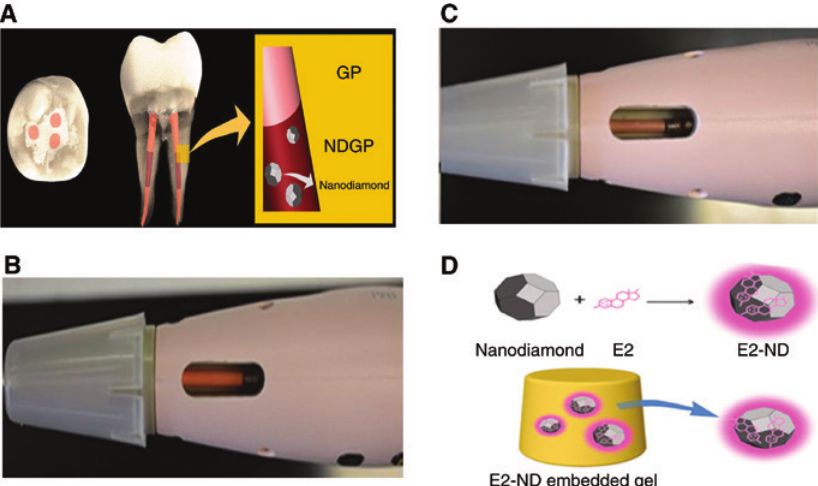
Figure 5: Clinical applications of nanodiamonds. (A) An illustration of NDGP in the middle third of the root canal and unmodified GP in the apical and coronal thirds of the root canal-treated tooth. (B) A view of unmodified GP in the dispensing unit. (C) A view of NDGP in the dispensing unit. Adapted from [78]. (D) A schematic of E2/ND complex embedded within a hydrogel matrix. Adapted from